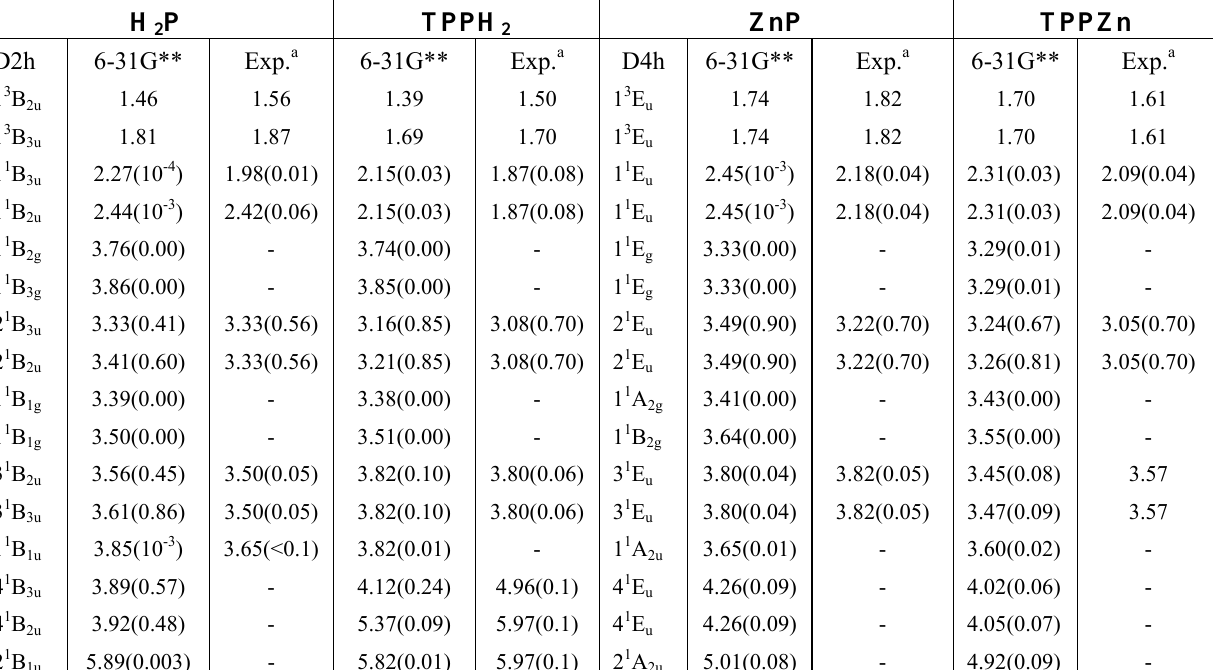
Table 1. Electronic absorption spectrum of the free-base porphyrin, Zn-porphyrin, and their tetraphenyl derivatives. Excitation energy is in eV, oscillator strength (f) is given in parentheses. Experimental gas-phase data are from ref